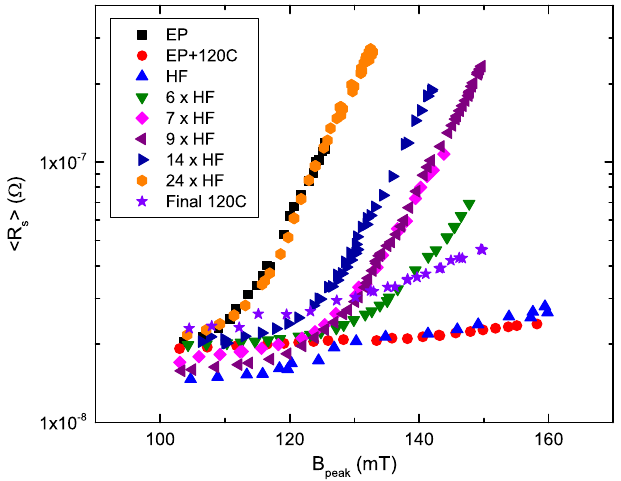
FIG. 9. Evolution of the high field Q slope with multiple HF rinse cycles for the electropolished cavity TE1ACC005. Notice gradual emergence of the high field Q slope as more and more niobium is consumed. Residual Q slope after 120 (cid:1) C bake mimicking HFQS is due to field